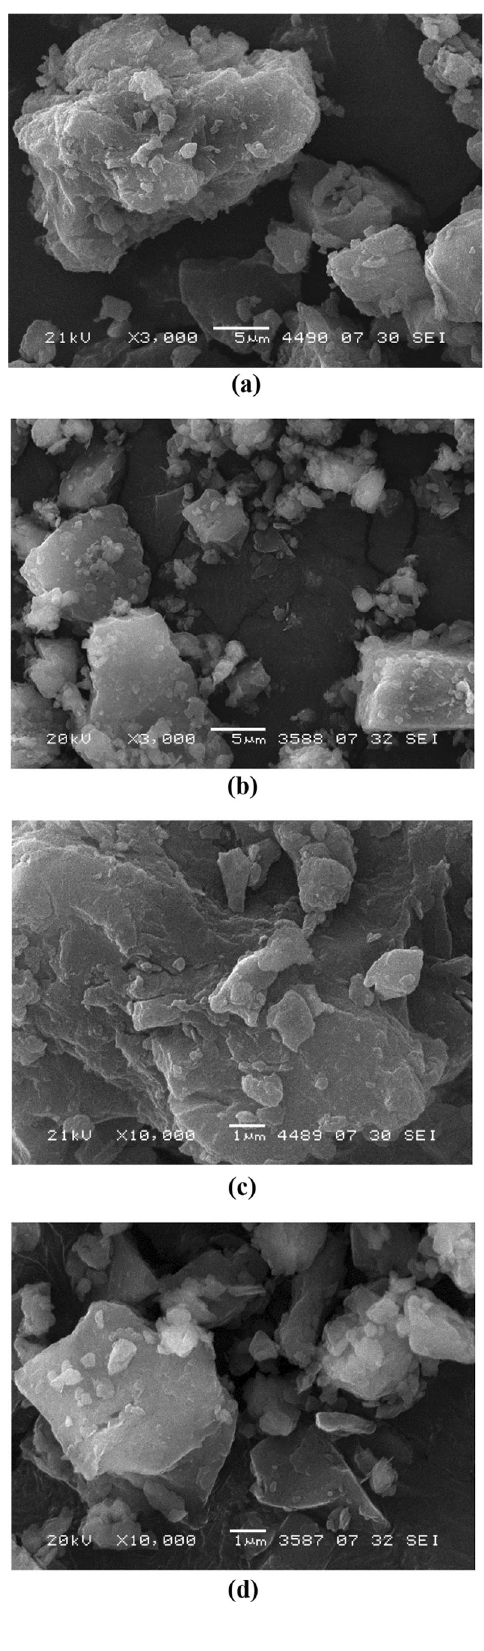
b Fig. 2 SEM images of the pristine coal samples: a , c refer to sample L; b , d refer to